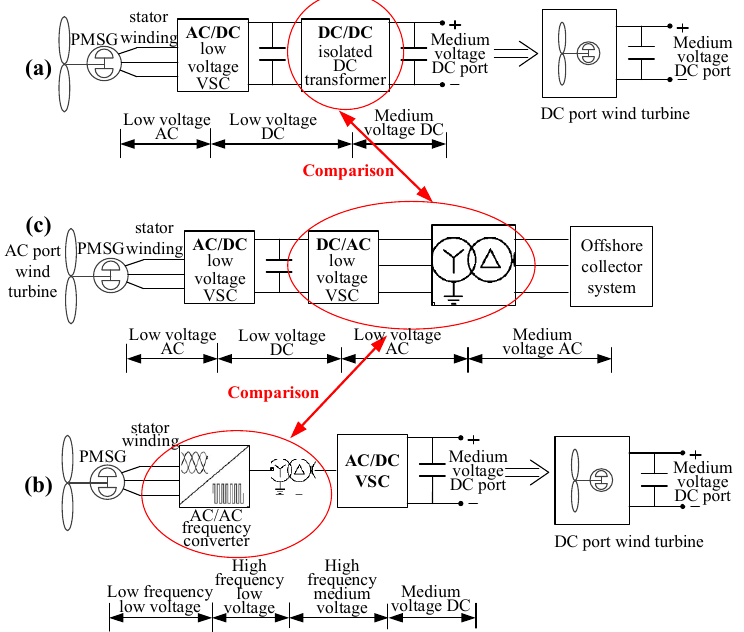
Figure 9. Two technical approaches to construct a DC-port wind turbine. ( a ) the first technical approach; ( b ) the second technical approach; ( c ) the conventional AC-port wind